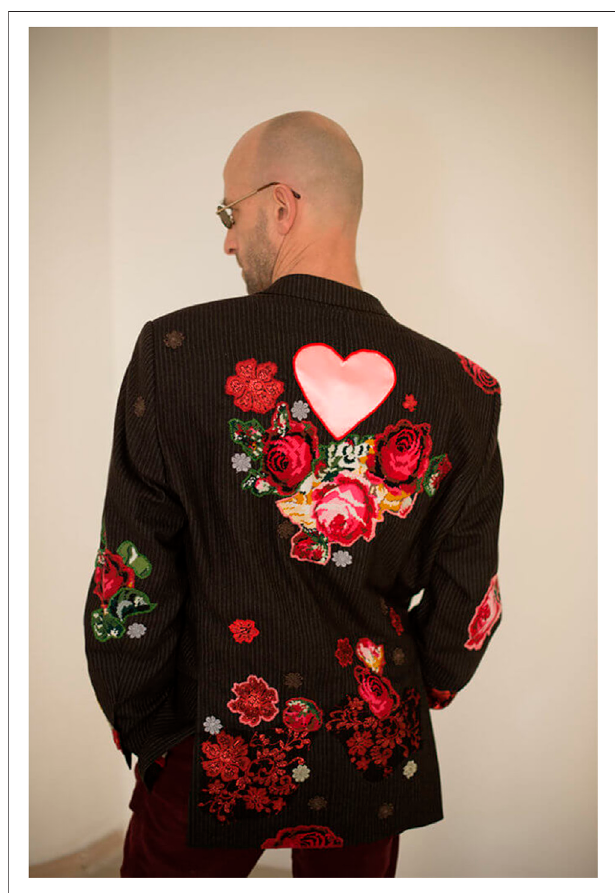
FIGURE 2 | From Oksana Briukhovetska ’ s series, “ Suit Jackets.